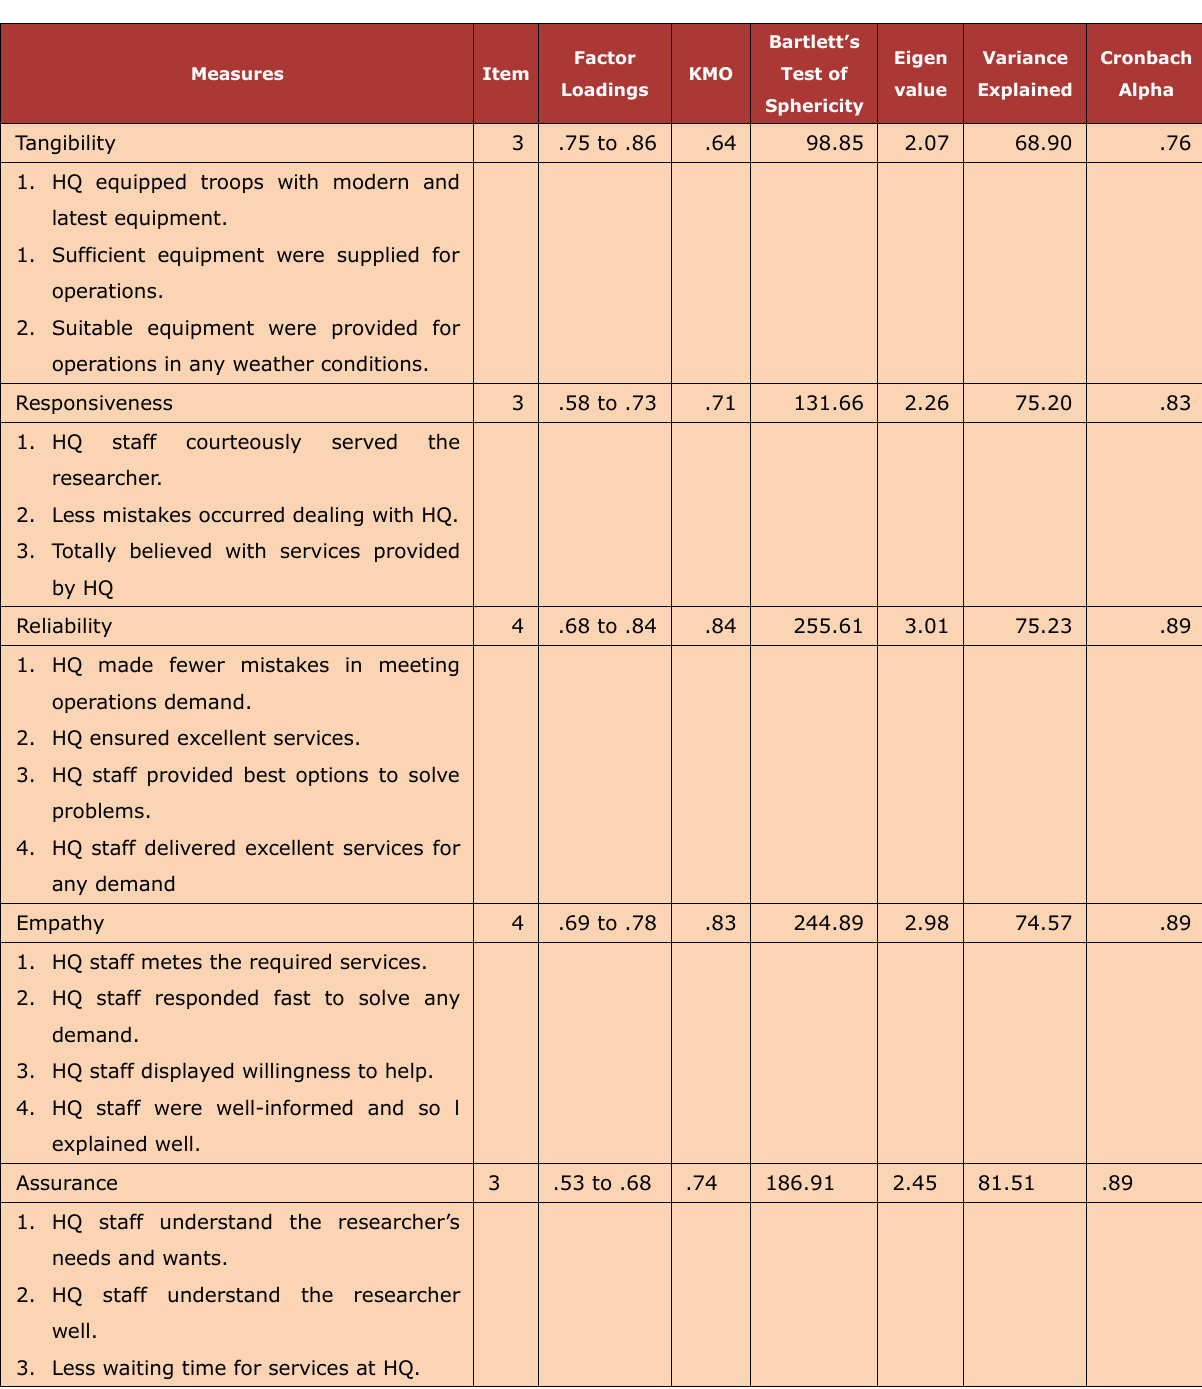
Table 3. Results of Validity and Reliability